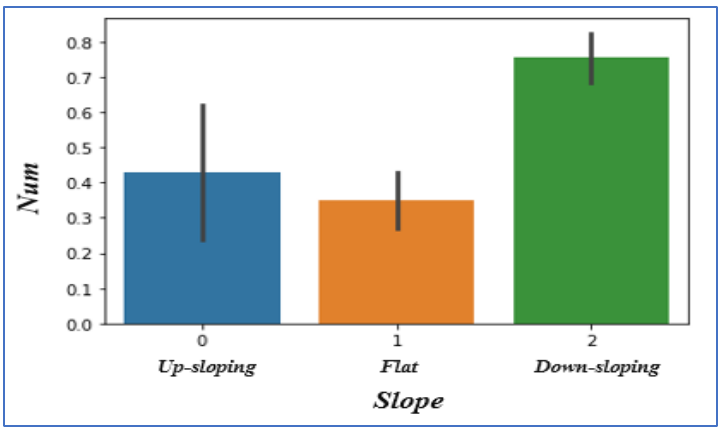
Figure 10. Slope vs. heart disease chances.